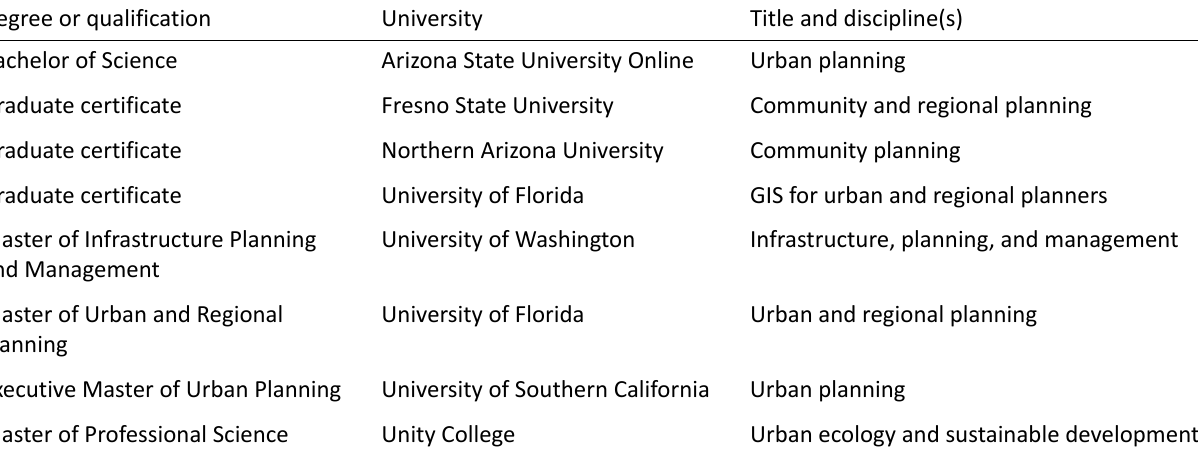
Table 1. Online urban planning and urban regeneration programs in higher